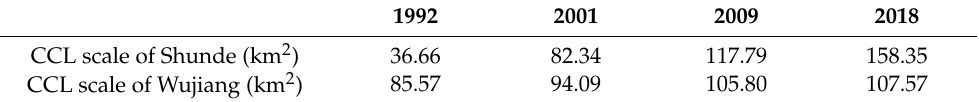
Table 1. The scale of collective-owned construction land in Shunde and Wujiang from 1992–2018.